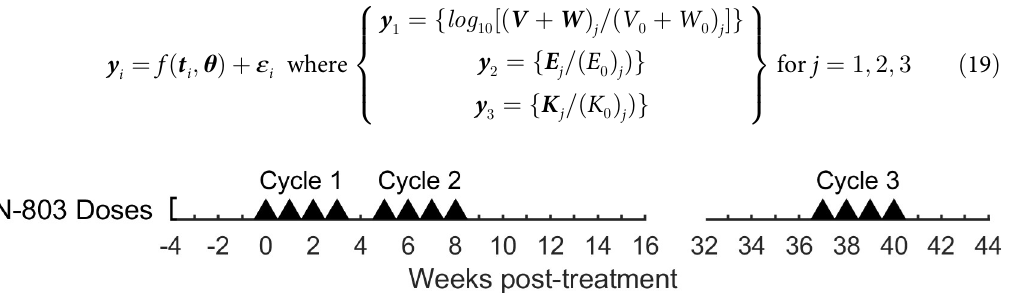
Fig 2. Dosing schedule for N-803 treatment of SIV-infected NHPs. Each triangle indicates a 0.1 mg/kg subcutaneous dose of N-803